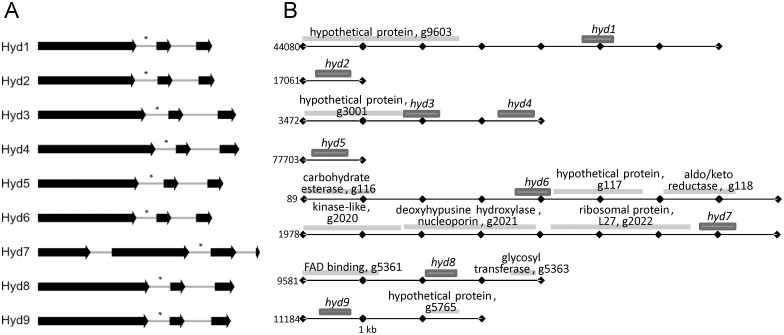
Gene and genomic structure of hydrophobins in T. vaccinum.(A) The exons of hydrophobin genes are visualized by arrows; the asterisk shows the position of the 5th cysteine residue within a splice site. (B) The genomic structure is presented for the scaffolds of T. vaccinum genome.